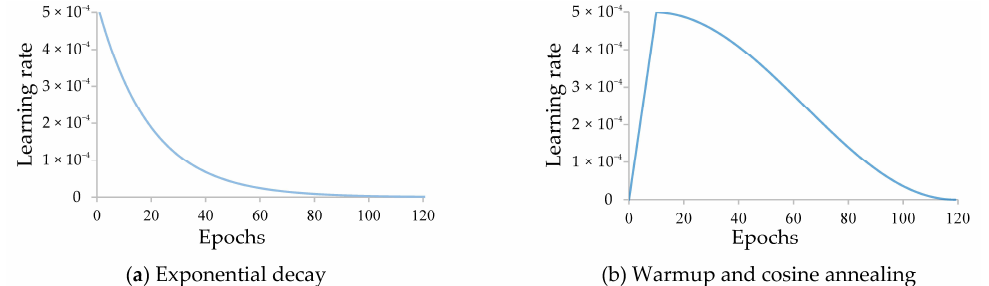
Figure 6. Comparison between two LR policies. The left figure ( a ) shows the exponential decay LR policy, while the right figure ( b ) shows the warmup and cosine annealing LR policy.